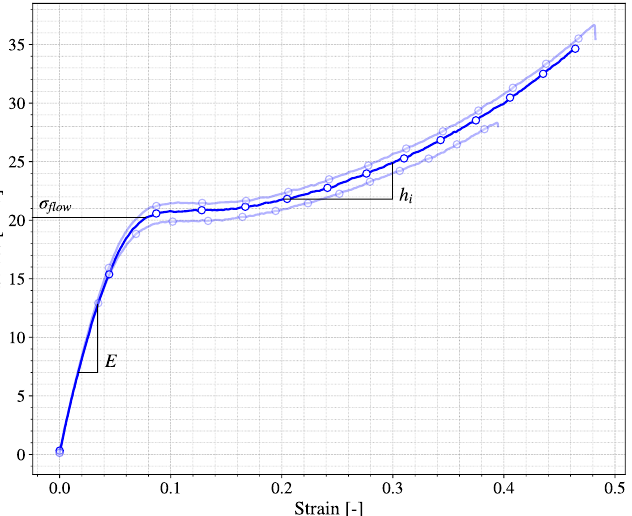
Figure 5. True stress versus true strain for a 45 ◦ printed specimen in quasistatic tensile